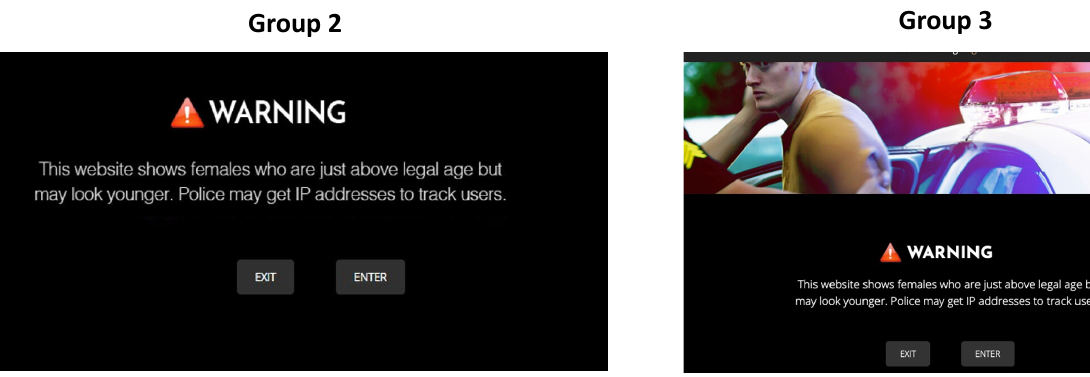
Figure 3. Examples of the messages shown during first experiment with a honeypot styled as the ‘barely legal’ pornography genre.